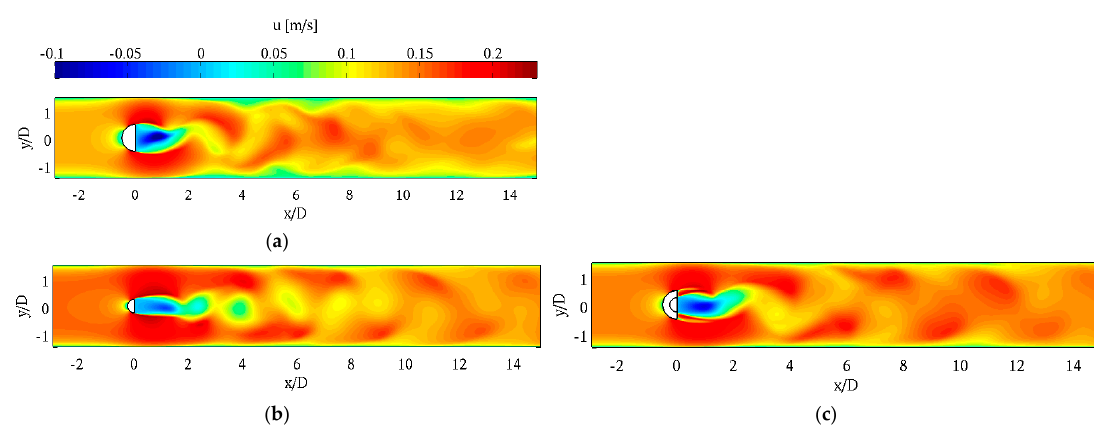
Figure 6. Streamwise velocity of the final time step ( t = 87.5 s) at ( a ) z / D = − 0.5; ( b ) z / D = 0.5; and ( c ) z / D = 0.0.